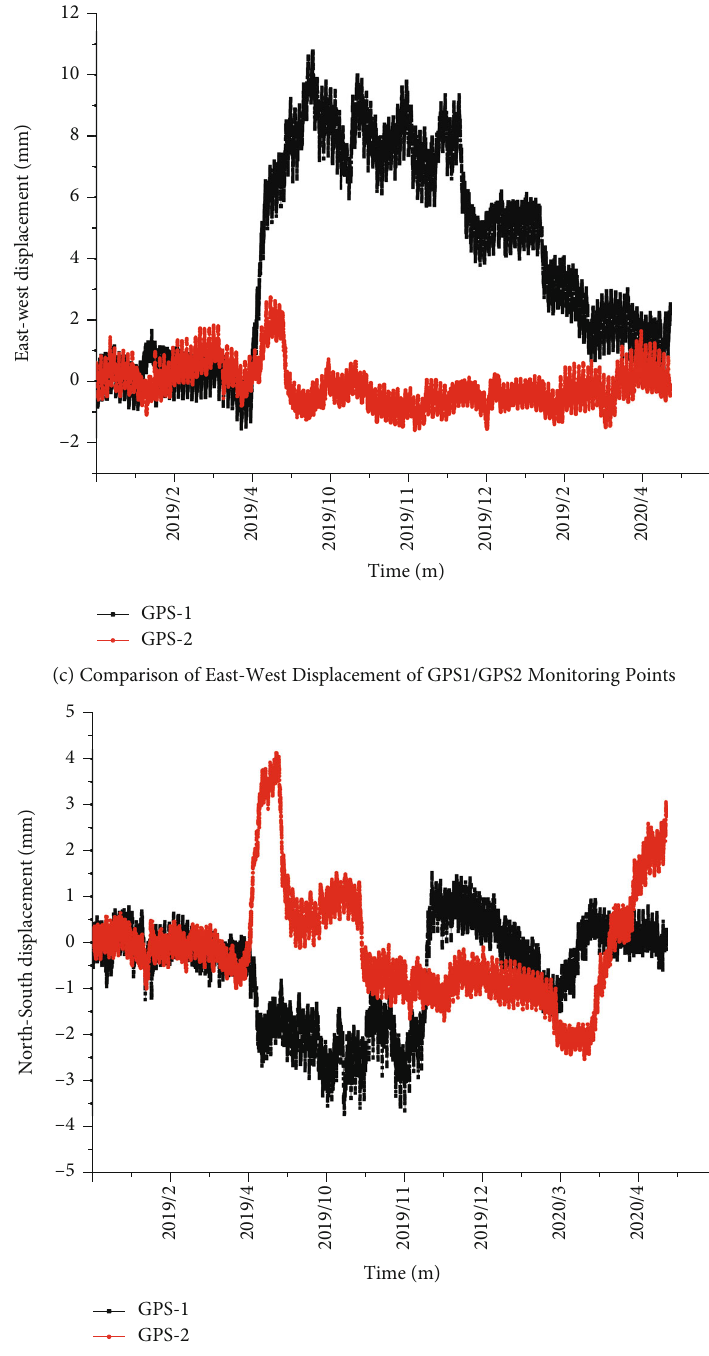
Figure 10: In situ monitoring